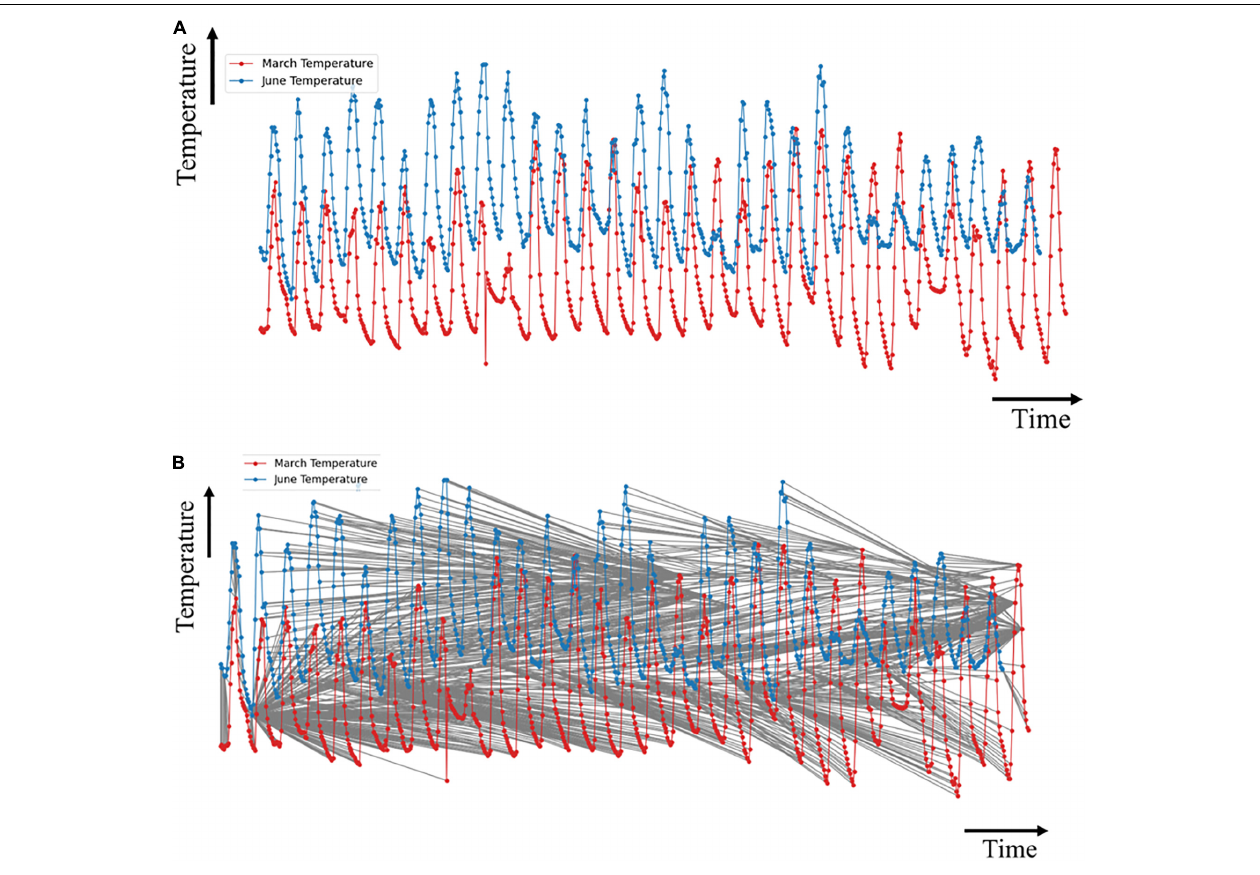
FIGURE 7 | Plots of temperature data for (A) March and June; and (B) optimal match of the time